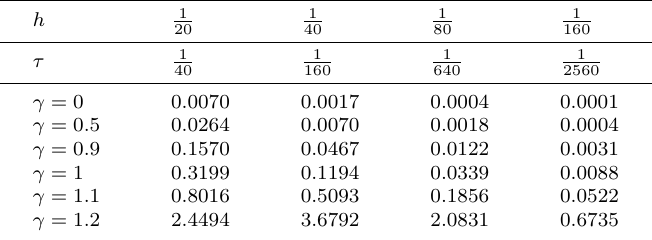
Table 1. The errors of solution in the case q ( x,y ) = 0, a = 1, T = 1; stability condition (4.3) is γ < 1.